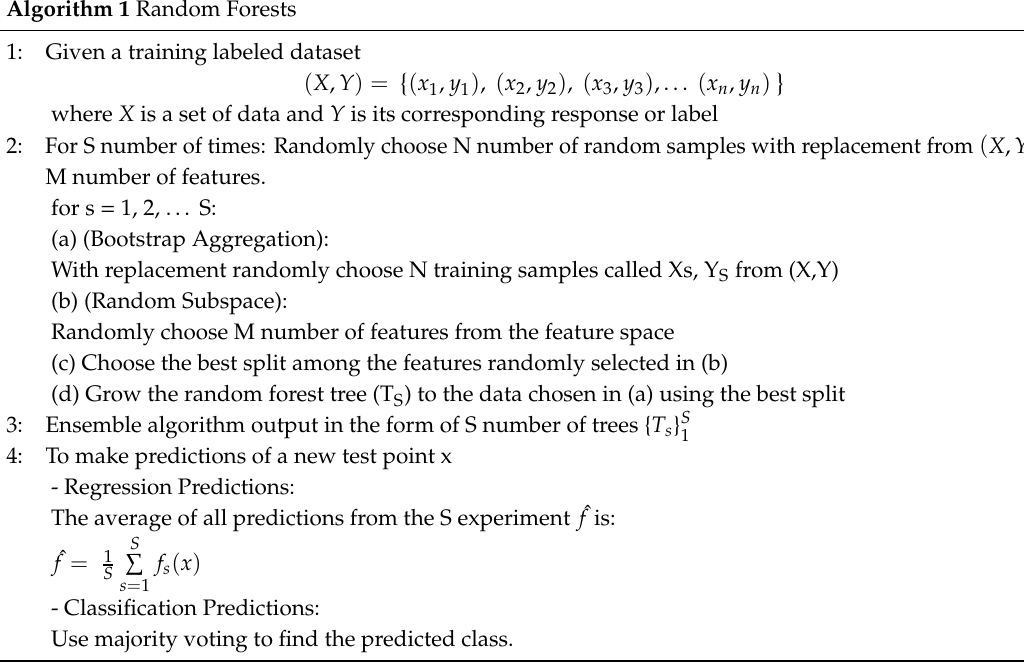
Algorithm 1 Random